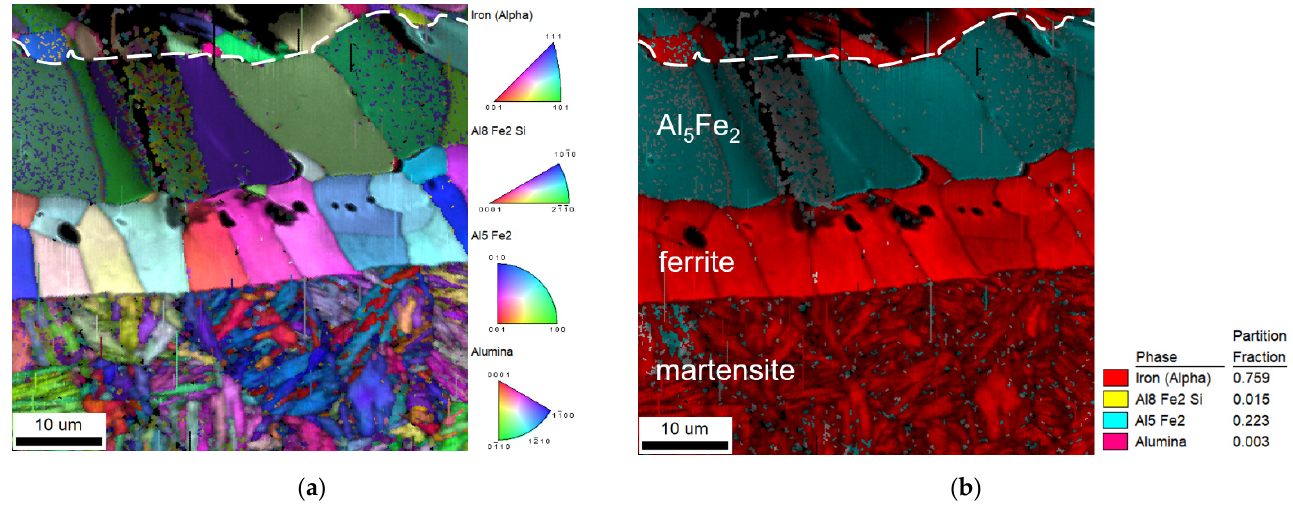
Figure 3. ( a ) IPF and ( b ) corresponding phase and IQ map of the coating–steel interface. The chemical differences between the BM and coating subzones were investigated by the EDS line scan (along the dark green line) and spot measurements (Figure 4). The marten- sitic microstructure of the BM (spots 1 − 3) is followed by a ferritic zone very rich in